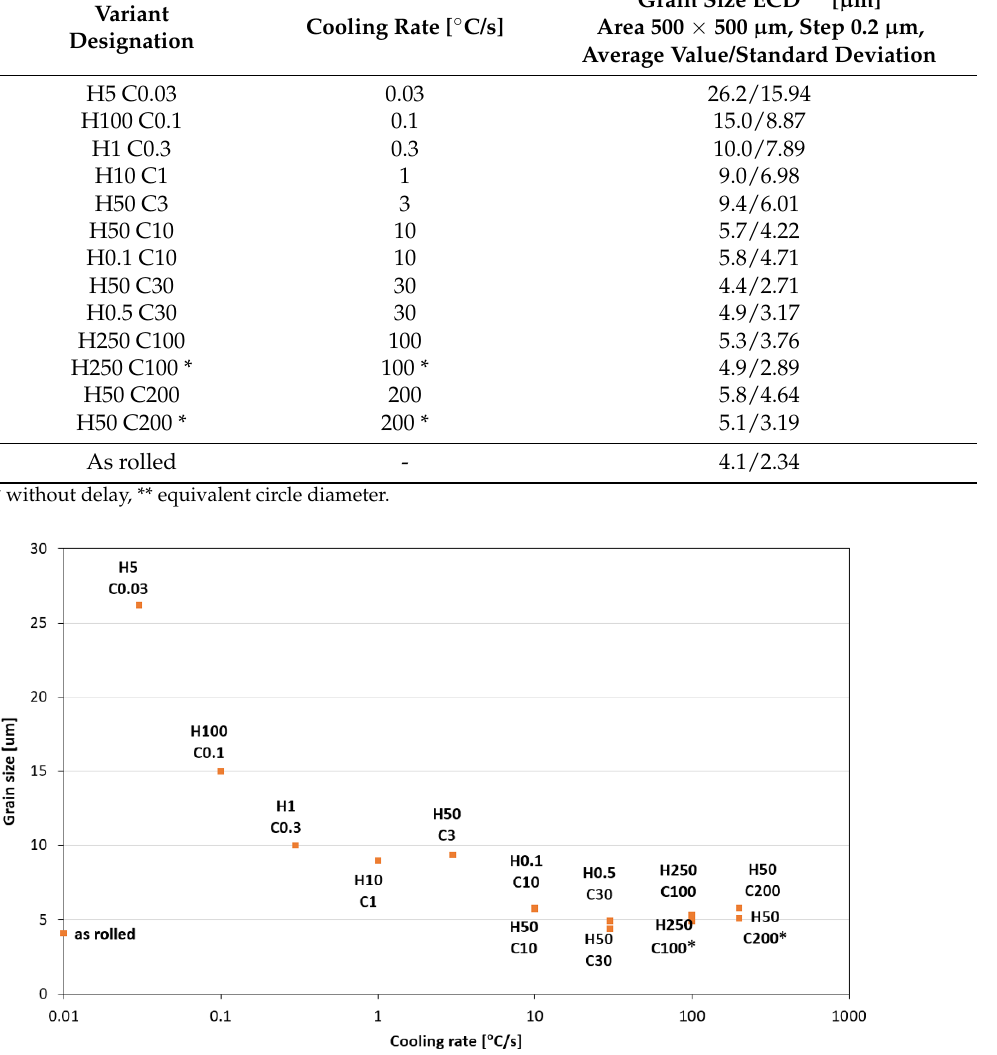
Figure 14. The EBSD analysis of grain size for different heating and cooling